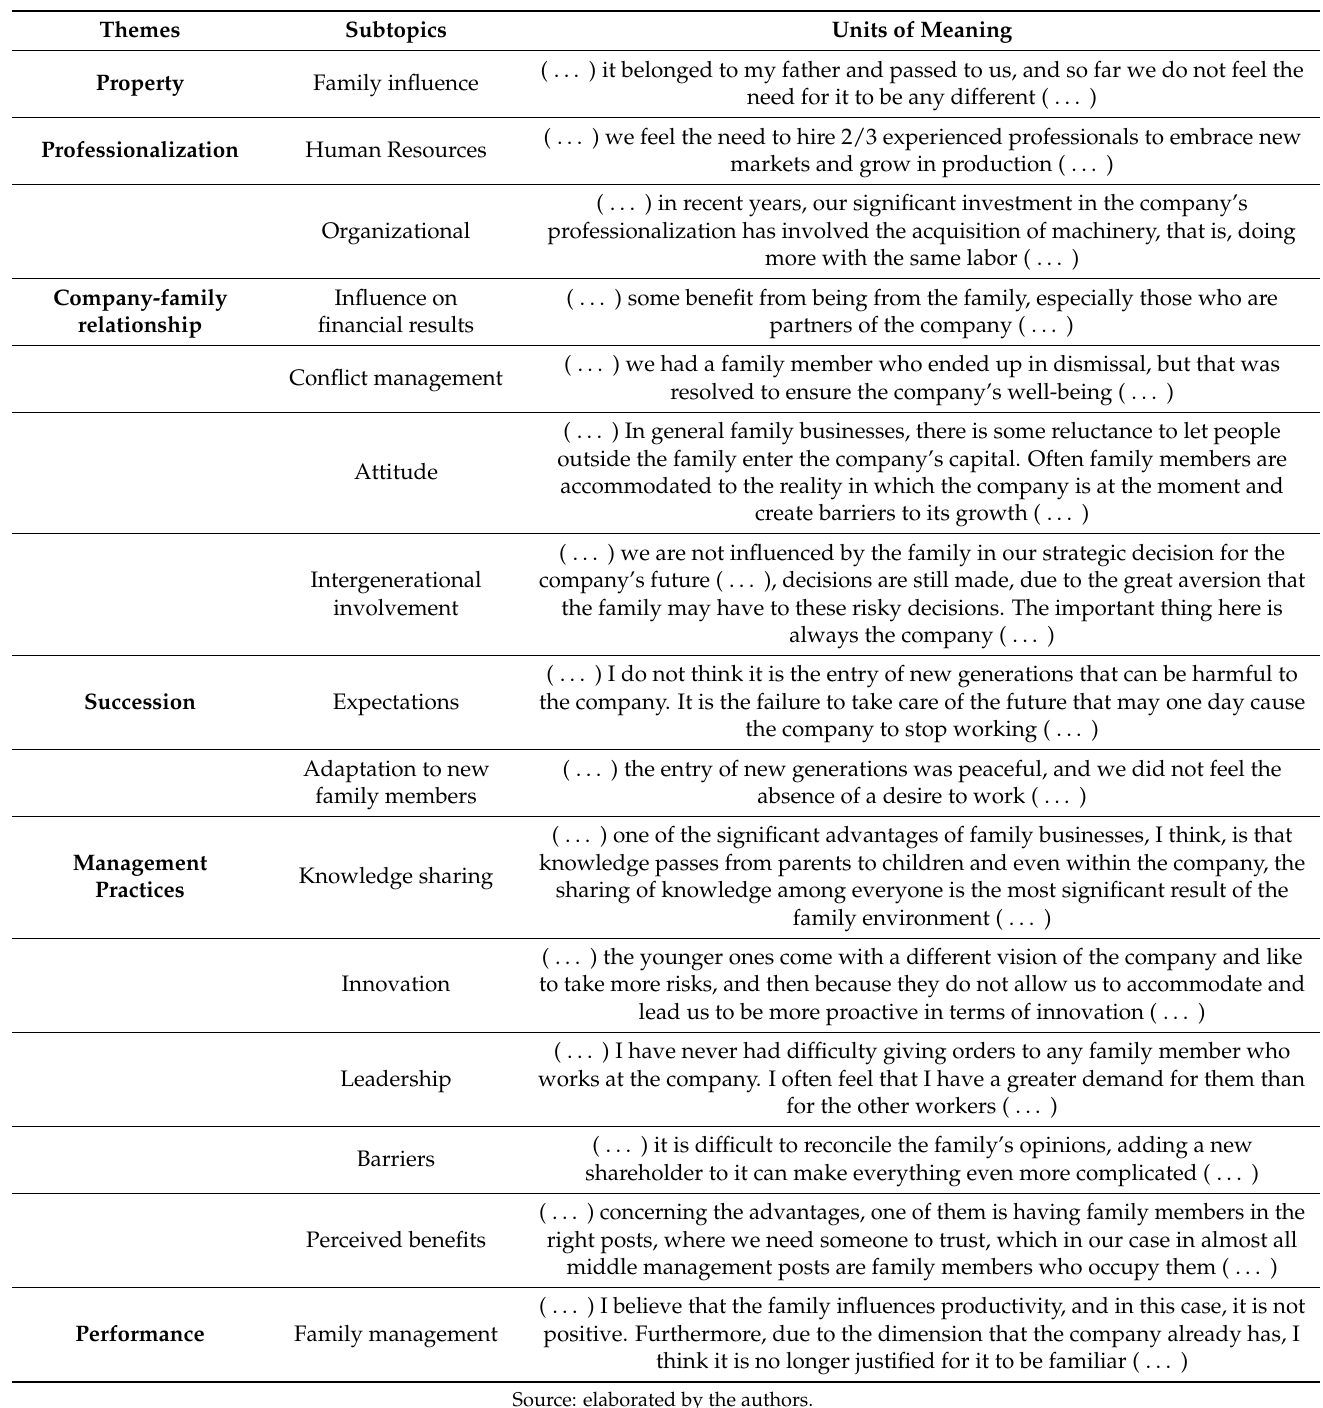
Table 3. Structure units of